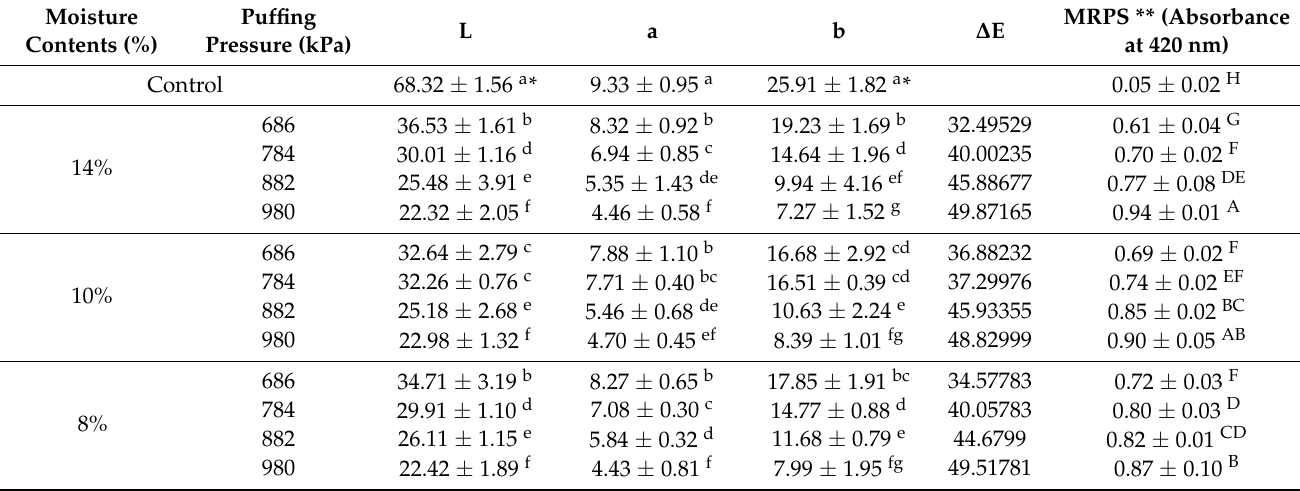
Table 3. Color and Maillard reaction products (MRPS) of puffed CWPG with different puffing pressure and moisture